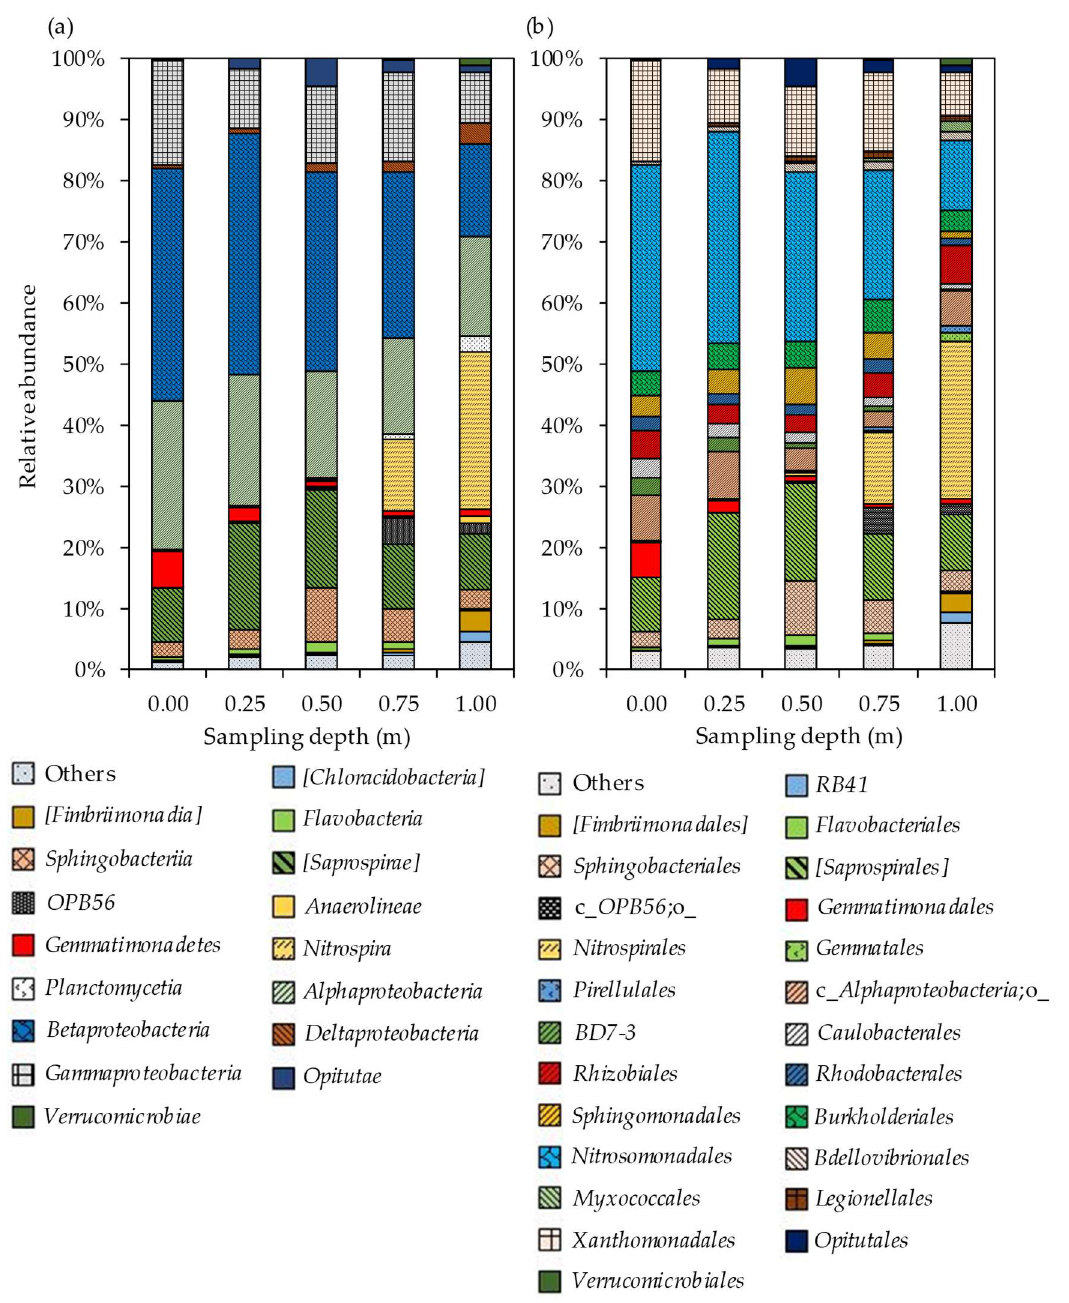
Figure 6. Bacterial community structures at the class ( a ) and order ( b ) levels along the single axis of the dropping flow on the 56th day of operation.